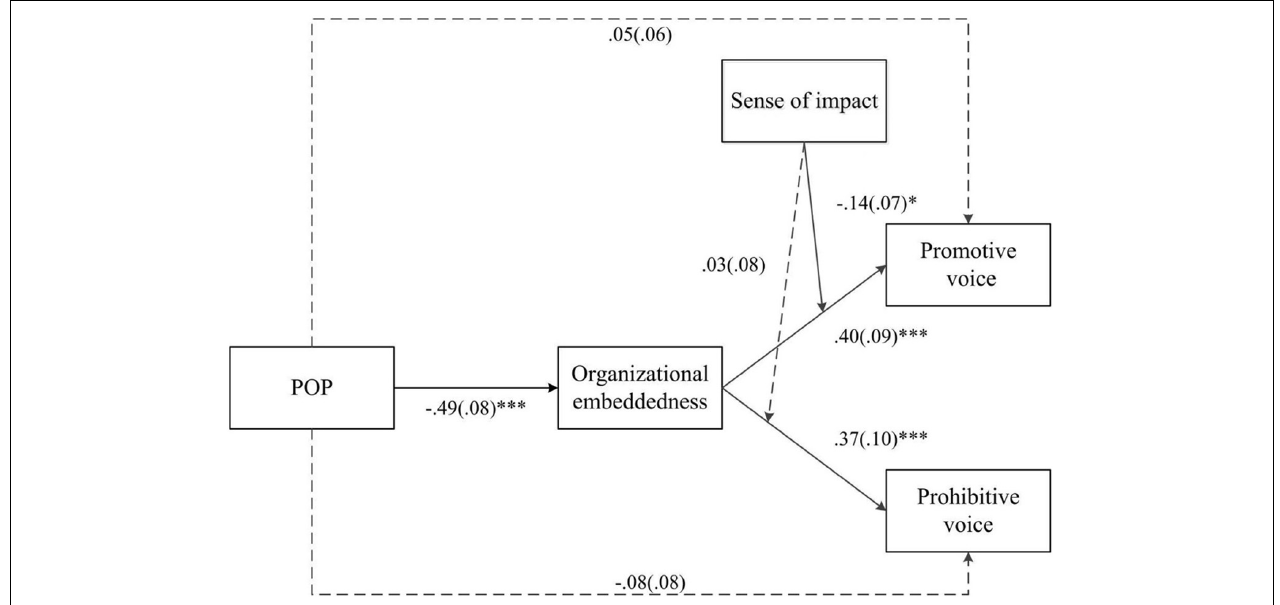
FIGURE 2 | Path coefficients of the conceptual model. N = 227. Path coefficients and standard deviations from the conceptual model. For brevity, we did not present the effects of the control variables. Interested readers may contact the corresponding author for estimates of these effects. ∗ p < 0.05, ∗∗∗ p < 0.001.